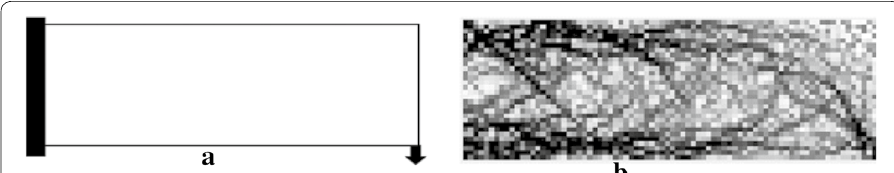
Fig. 8 a Design domain and b generated material distribution